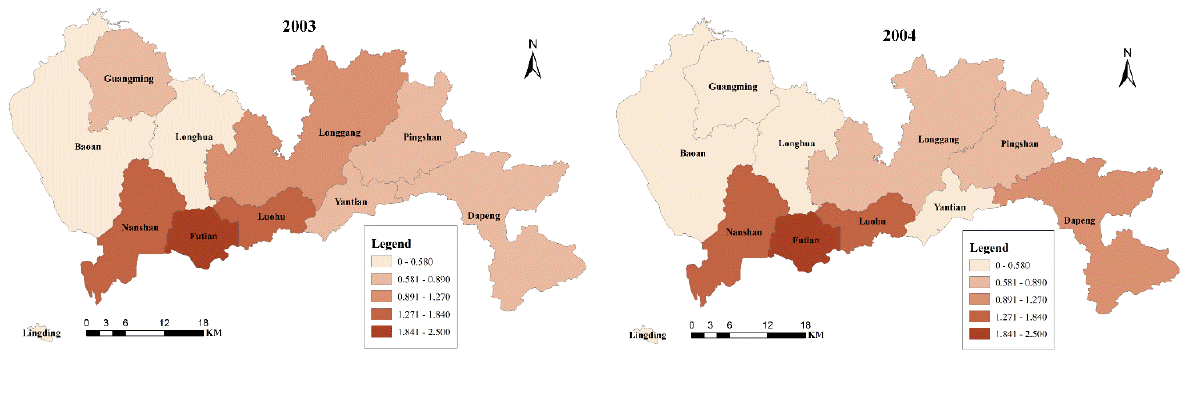
Figure 6. The IHD SRs of the districts in Shenzhen from 2003 to